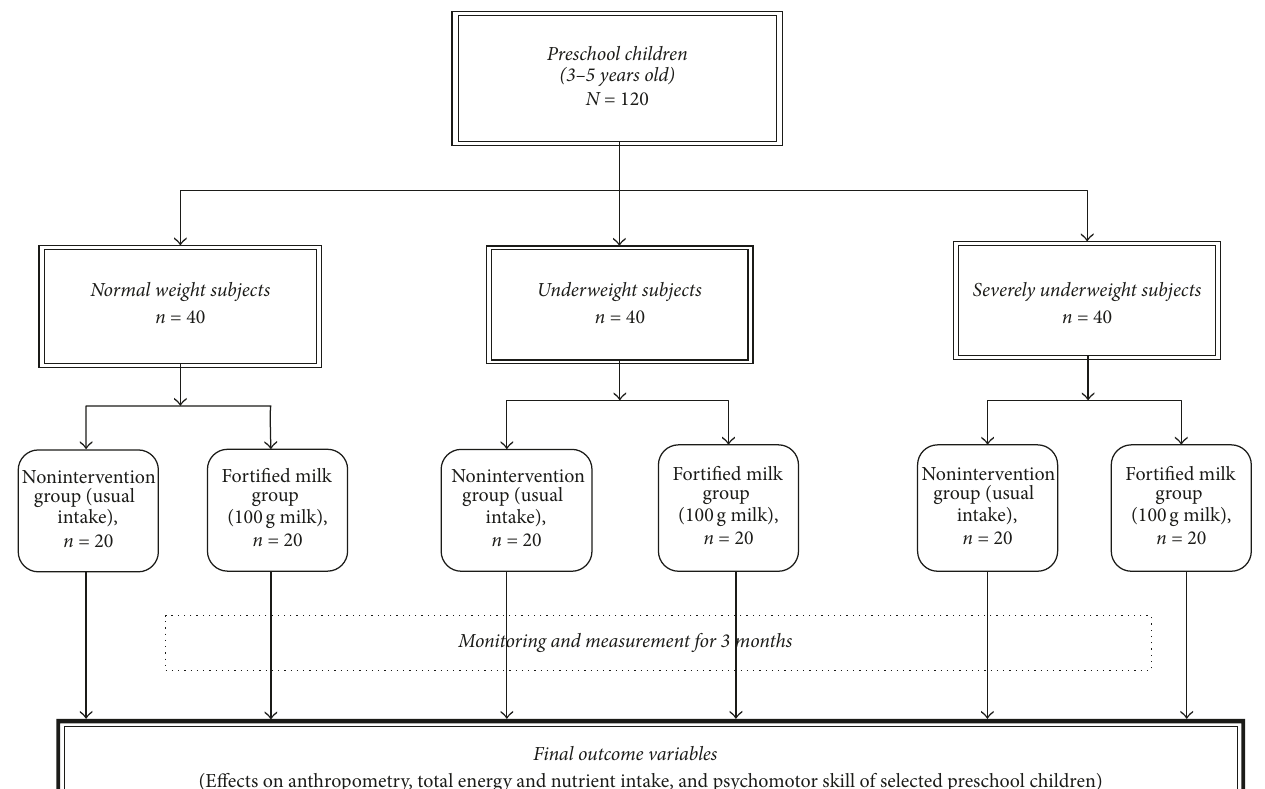
Figure 1: Experimental design ( 𝑛 = 120